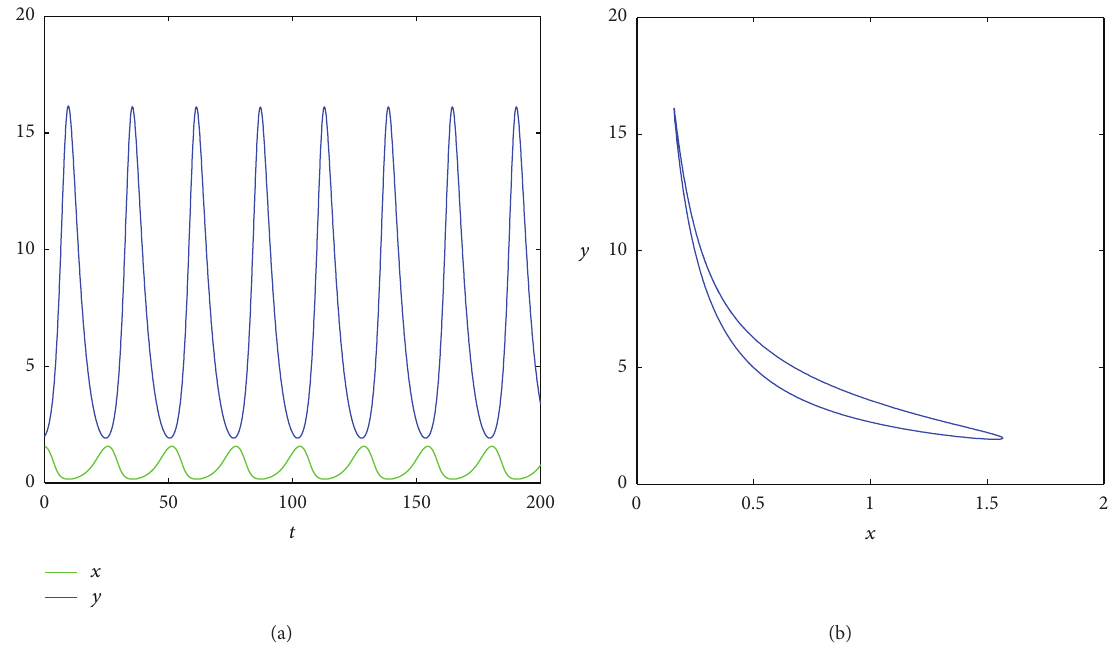
Figure 3: (a) Solutions for nutrients and phytoplankton where 𝐼 = 1 . 3, 𝜏 = 5. (b) Phase